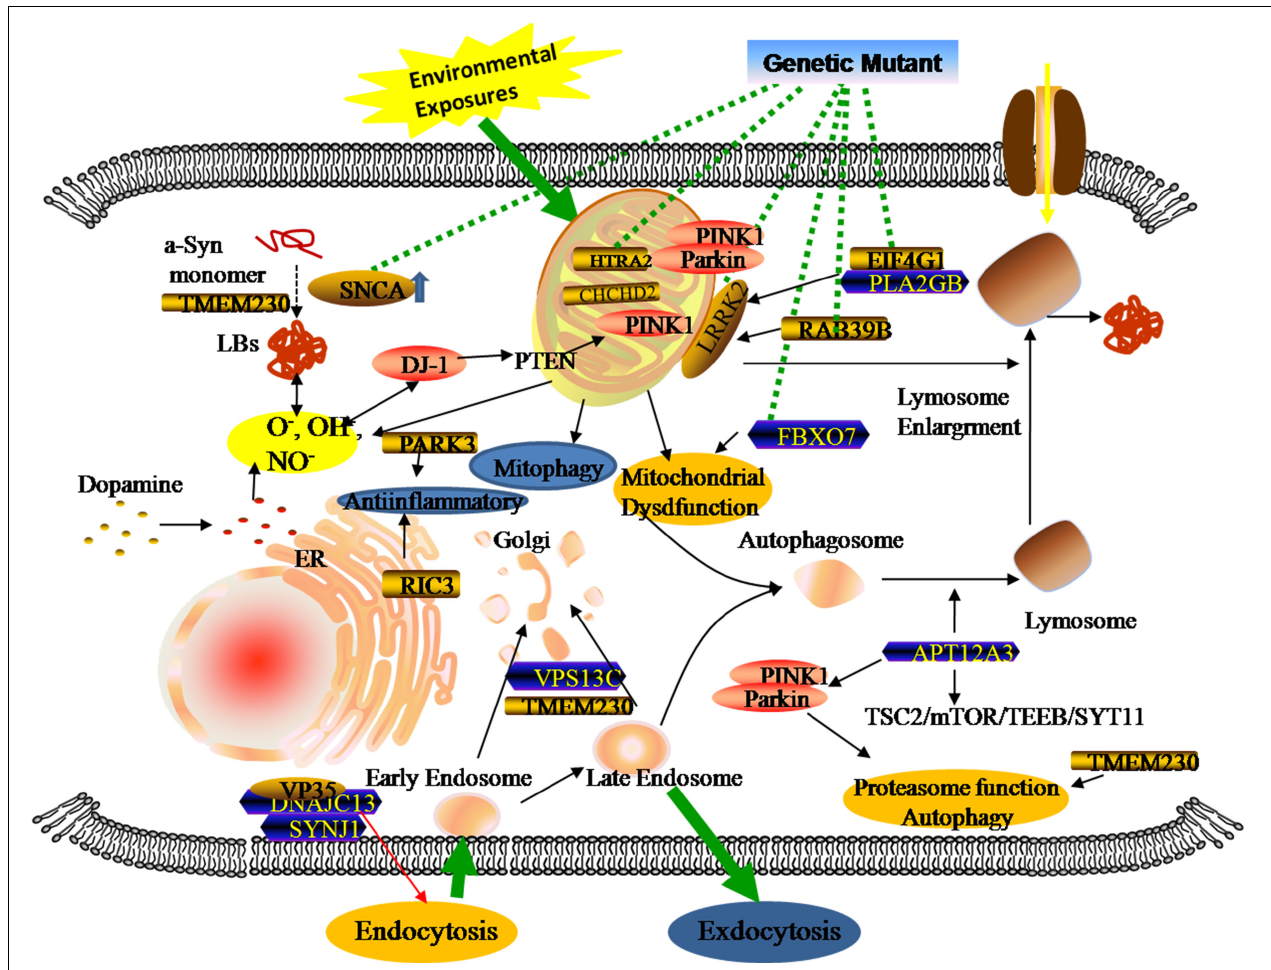
FIGURE 2 | Genetic metabolomics in PD. The complexity of the pathology of PD stemming from the overlap of multiple gene mutants and complex environmental factors. Both locally and systemically, these hazards contribute to a series of responses associated with mitochondrial dysfunction, neuroinflammation, and the failure of clearance